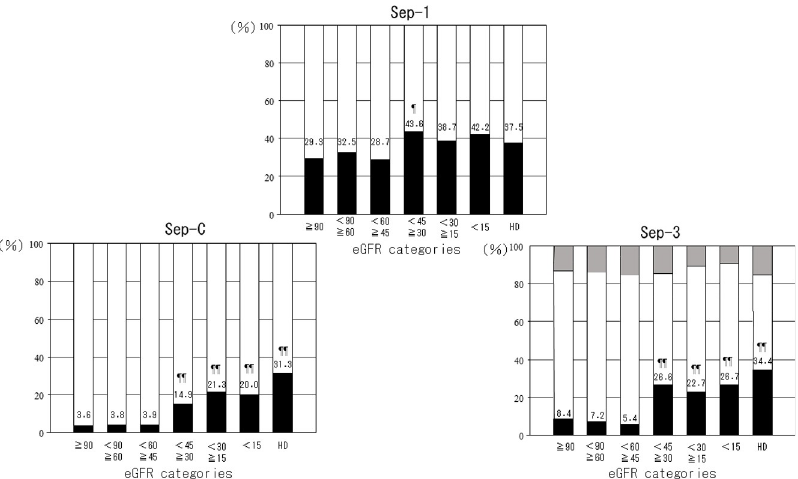
Fig 3. Percentages of patients with sepsis according to eGFR categories. Sep-1: sepsis diagnosed by Sep-1 criteria; Sep-C: sepsis diagnosed according to medical records; Sep-3: sepsis diagnosed by Sep-3 criteria. Black bars show patients with sepsis, white bars show patients without sepsis, and gray bars show subjects who were not evaluated because of lack of data. The numbers in the figure show percentages of patients with sepsis. p values calculated by logistic analysis adjusted by sex and age. ¶ p < 0.05, ¶¶ p < 0.01 compared with � 90.